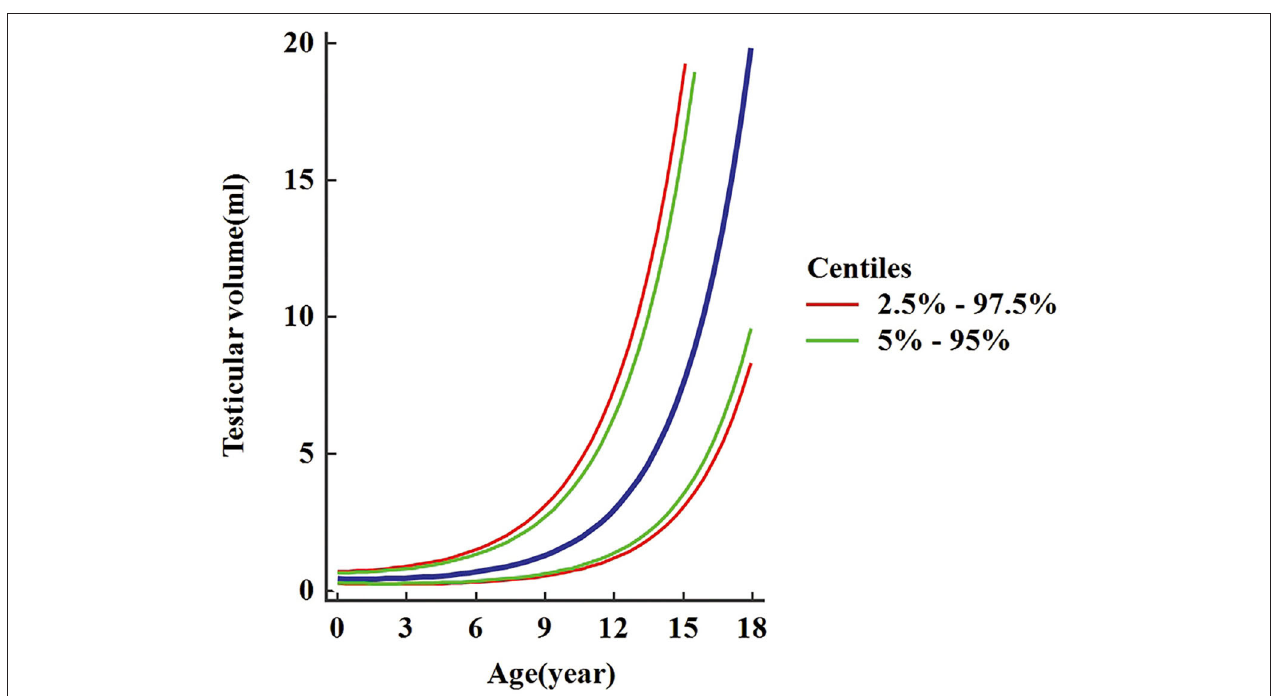
FIGURE 4 | Regression results for the y (age) and percentile curve of testicular volume.